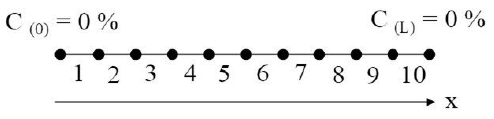
Fig. 1. Structure of the lattices: (a) dual Delaunay triangles and Voronoi polygons for thermo-mechanical or hydro-mechanical coupling; (b) conduit element Table 1. Mix-designs for the concrete